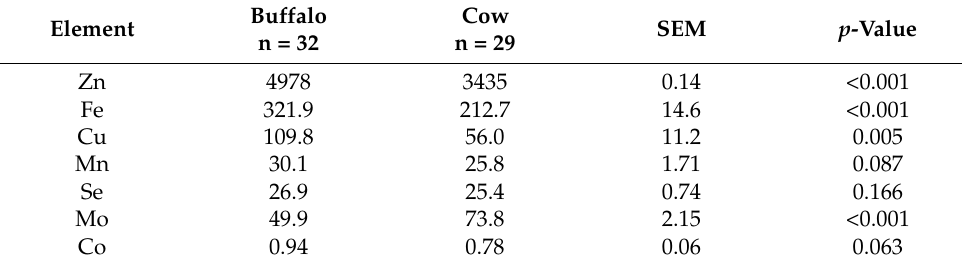
Table 2. Essential trace element concentrations ( µ g/L) in buffalo and cow